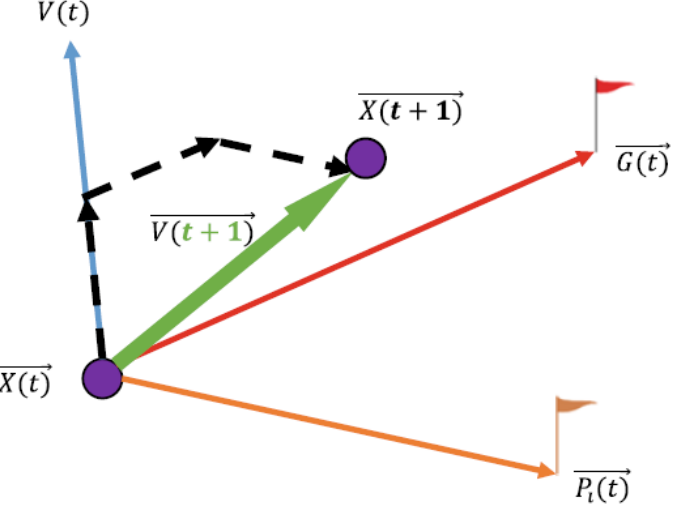
Figure 4. The details of the particle swarm optimization (PSO) components including location and velocity of particles.